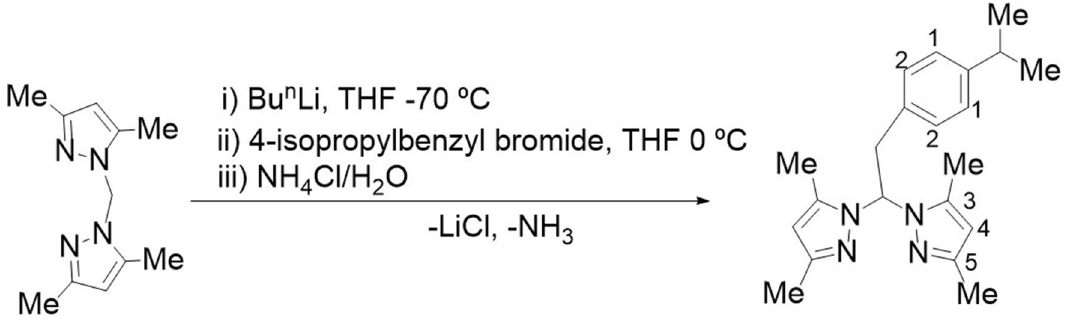
Figure 2. Synthetic route for compound 2P.